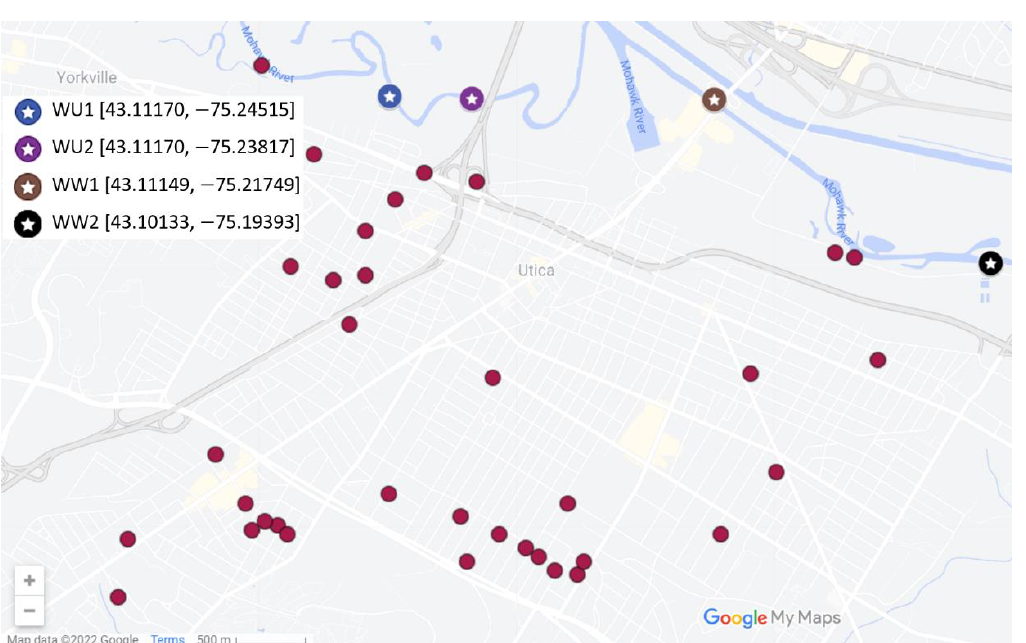
Figure A1. CSO locations throughout the city of Utica NY. CSO locations are from “Combined Sewer Overflows (CSOs): Beginning 2013” available dataset from data.ny.gov [29]. Sample sites are also marked on the map.